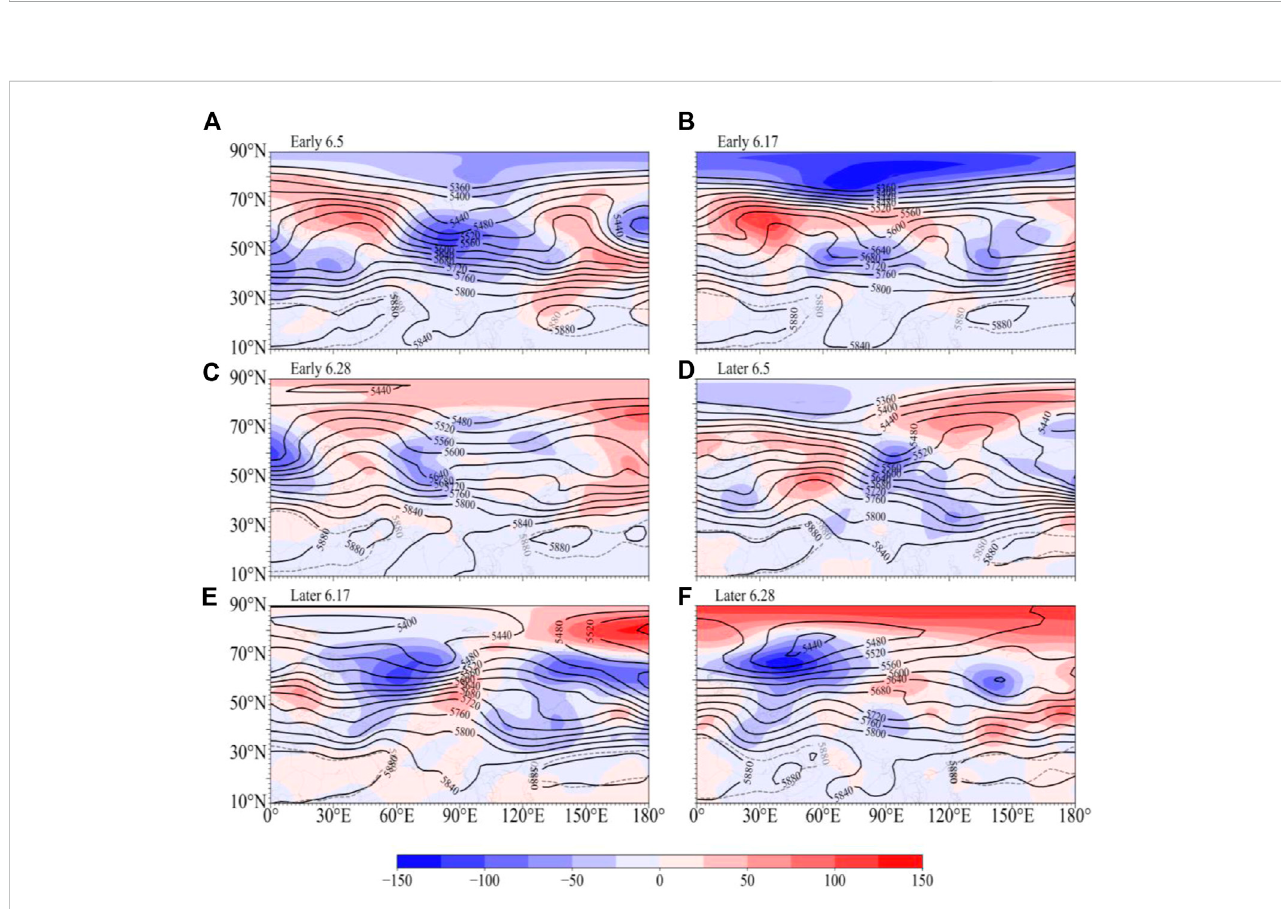
FIGURE 4 The characteristics of the 500 hPa geopotential height (unit: gpm) in the early and late years of the Meiyu onset date in the Yangtze-Huaiher River Basin (Shadedarea:anomaly,blacksolidline:height fi eld,graydottedline:climaticaveragepositionofsubtropicalhigh). (A) :June5thinearlyyears (B) :June17thin early years (C) : June 28th in early years (D) : June 5th in later years (E) : June 17th in later years (F) : June 28th in later